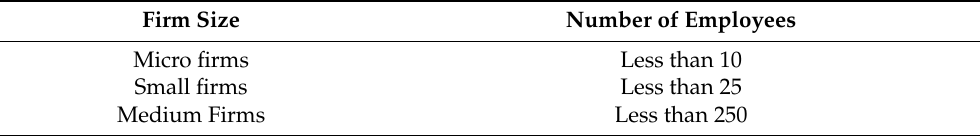
Table 1. Definition of SMEs. Firm Size Number of Employees Micro firms Less than 10 Small firms Less than 25 Medium Firms Less than